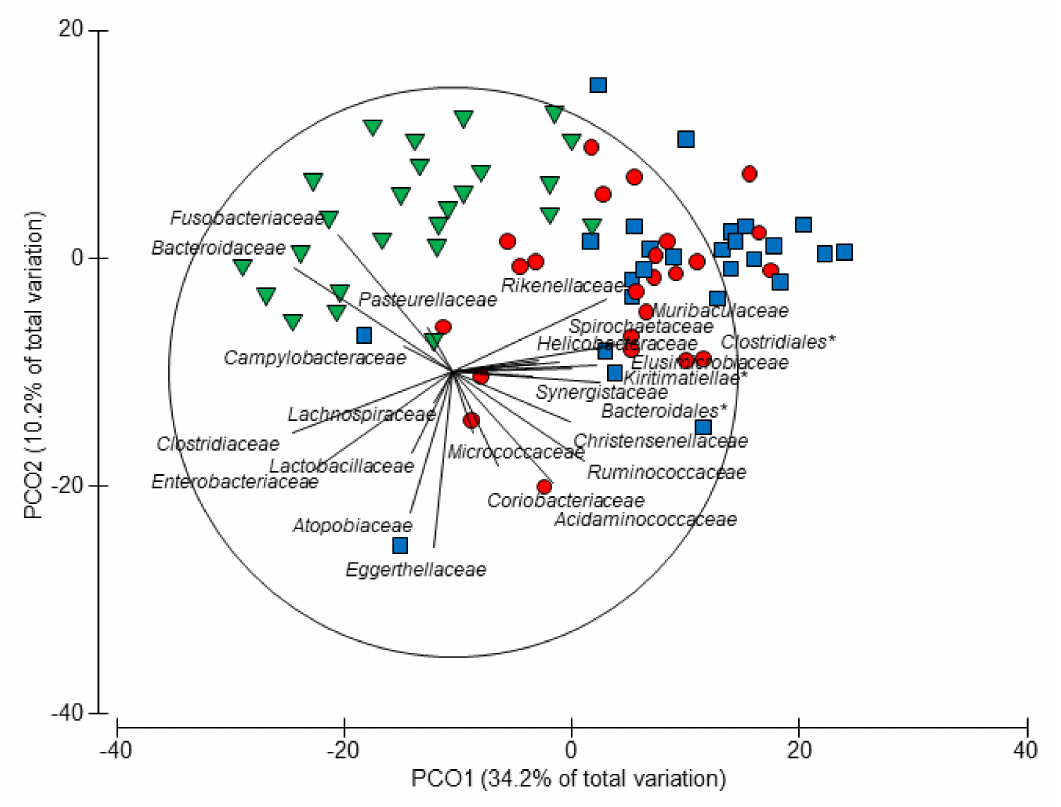
Figure 4. Principal coordinate analysis (PCO) ordination of faecal bacterial families from piglets at 7 (inverted triangle), 13 (circle), and 18 (square) days of age. Overlaid onto the PCO are vectors of the subset of 24 taxa identified by the BVSTEP procedure (Rho = 0.951, P = 0.001) to best represent the overall community pattern from the full set of 81 identified families. Vectors indicate the association of the families with a particular diet. * Uncharacterised family. Table 1. Family contributing to the top 70% of significant dissimilarity of bacteria between 7 and